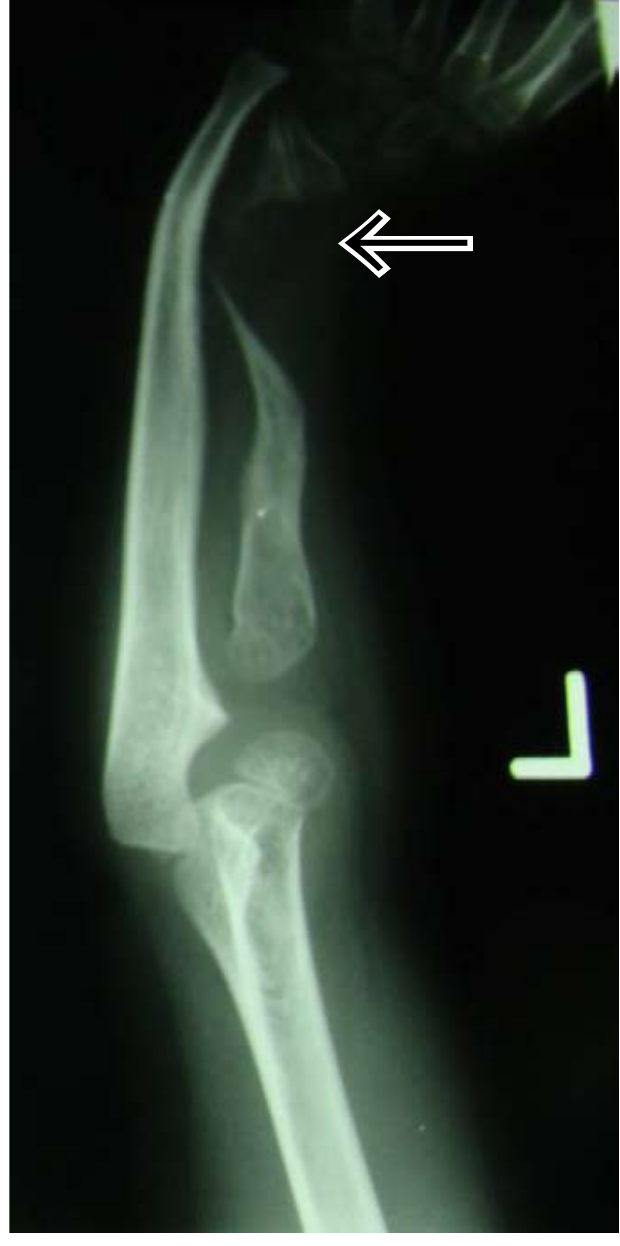
Fig. 13b. Anteroposterior X-ray of the forearm with thinned atrophic distal